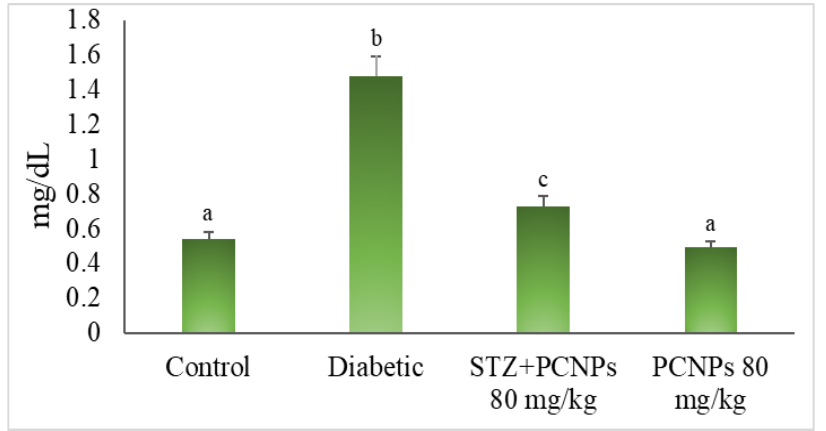
Figure 5. Activities of PCNPs on urea of experimental and control group. Values are mean ± SD for six rats at p < 0.05 (DMRT). a PCNPs alone treated group compared with control group. b Diabetic group compared with control group. c Treatment group compared with diabetic control.